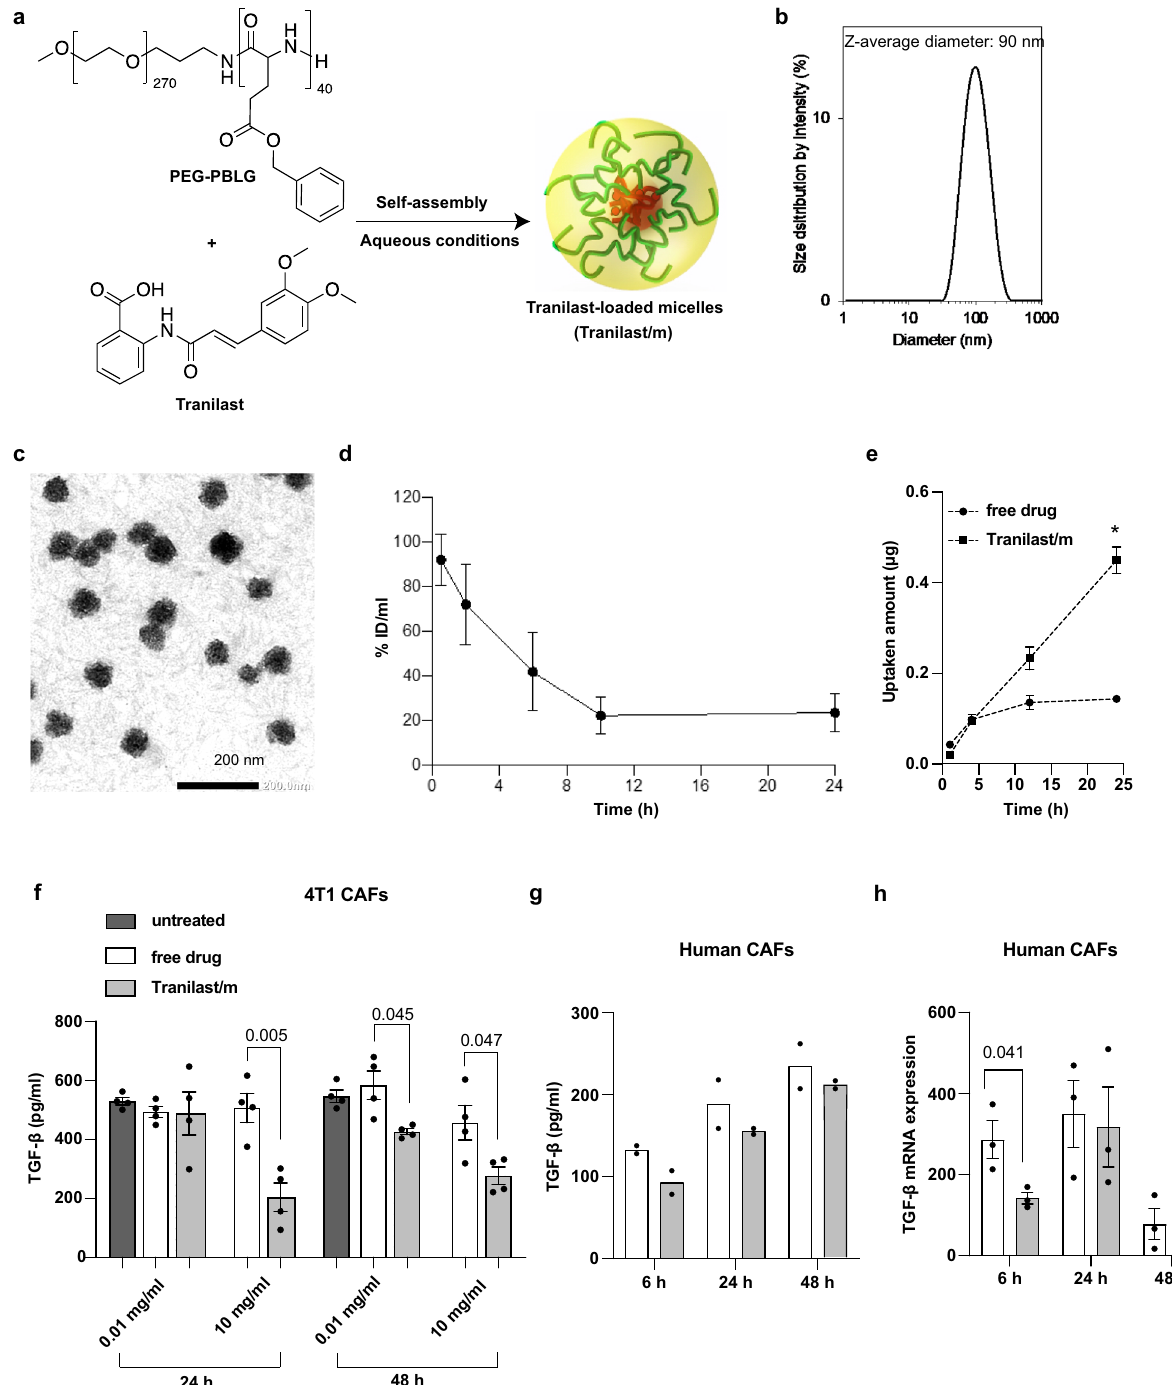
Fig. 1 | Characterization of tranilast-loaded micelles. a Schematic of tranilast- loaded micelles (Tranilast/m) preparation. The micelles were self-assembled by mixing PEG-PBLG and tranilast in aqueous conditions. b Size distribution of Tra- nilast/m determined by dynamic light scattering (DLS). c Transmission electron microscopy observation. d Time-dependent decay of plasma concentration after intravenous injection of 2mg/kg Tranilast/m on tranilast basis. Data shown as the mean±SD( n =4mice). e Tranilastuptakeby4T1-derivedCAFsovertimemeasured by HPLC. Data shown as the mean ± SD ( n =3 independent samples). f Quanti fi cation of TGF- β expression in conditional medium secreted by CAFs isolated from 4T1 breast tumors, following incubation with free tranilast or PEG- PBLGtranilastloadedmicellesataconcentrationof0.01and10mg/mlfor24hand 48h.Datashownasthemean±SD( n =8independentsamplesforuntreatedgroup, n =4 independent samples for treated group). g TGF- β 1 protein concentration in